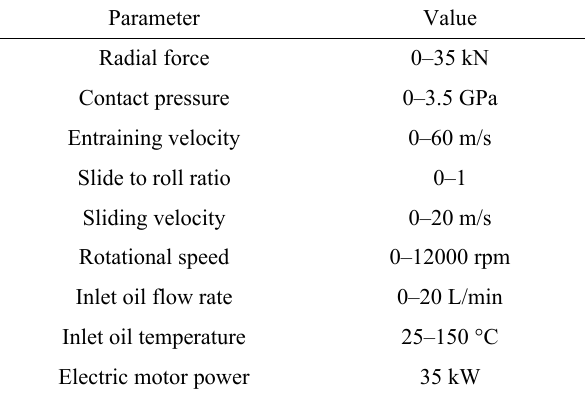
Table 2 Main parameters of twin disc